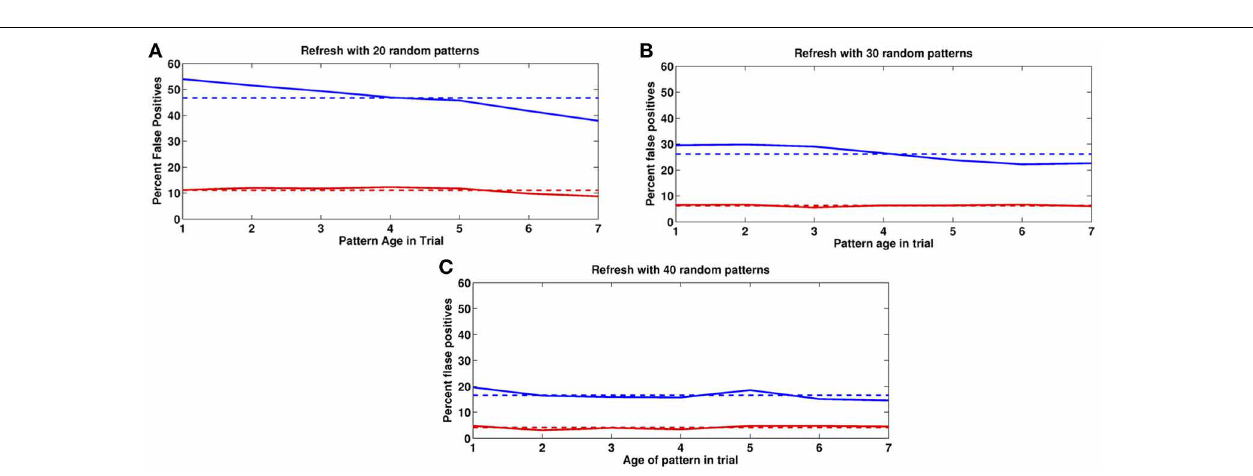
FIGURE 8 | Detection rates and false positives for different levels of p fire . Left: p fire = 0 . 4, Middle: p fire = 0 . 45, Right: p fire = 0.5. Top: detection rates, Bottom: false positive probability for repetition of a pattern from 1 to 6 trials back.